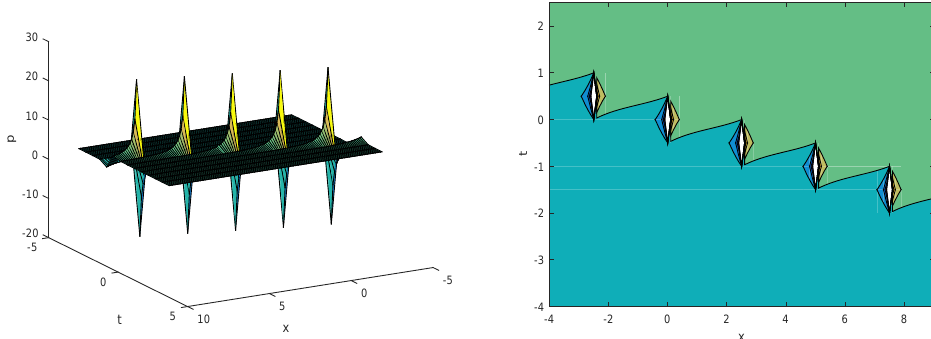
Figure 1. The above graphs show the graphical illustration of solitons in the form of the surface plots (on the left) and contour plots (on the right side) of acoustic pressure p where the values of parameters are mentioned below in A. This graph represents the behavior of solitons of Equation (17) which is a lump wave with a background or a lump wave with a kink background.